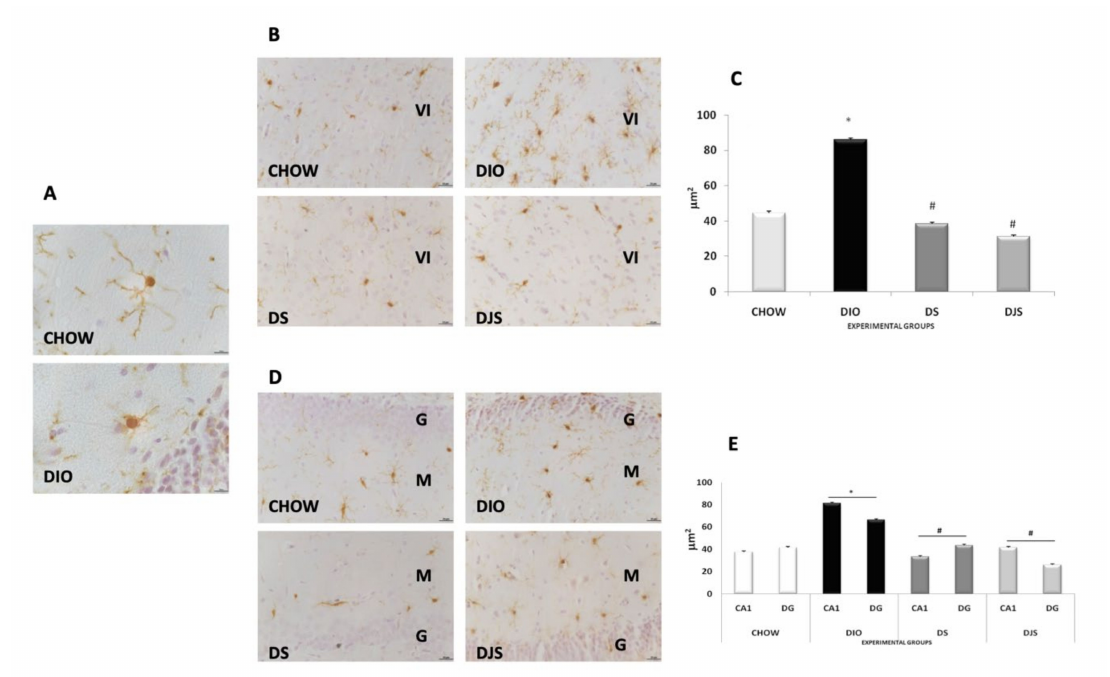
Figure 5. Microglial reaction. Immunohistochemical analysis of microglial IBA-1-positive cells in the frontal cortex ( A and B ) and dentate gyrus ( D ). In DIO rats, an increase of the soma and a reduction of arborizations of glial cells were noticeable (A). Morphometric analysis of the area of the soma in the di ff erent experimental groups in the frontal cortex ( C ) and hippocampus ( E ). VI, sixth layer of the frontal cortex; G, granular layer of the dentate gyrus; M, molecular layer of the dentate gyrus. The values are the mean ± S.E.M.; ∗ p < 0.05 vs. CHOW rats; # p < 0.05 vs. DIO rats. Calibration bar: panel A: 10 µ m; panels B and D: 25 µ